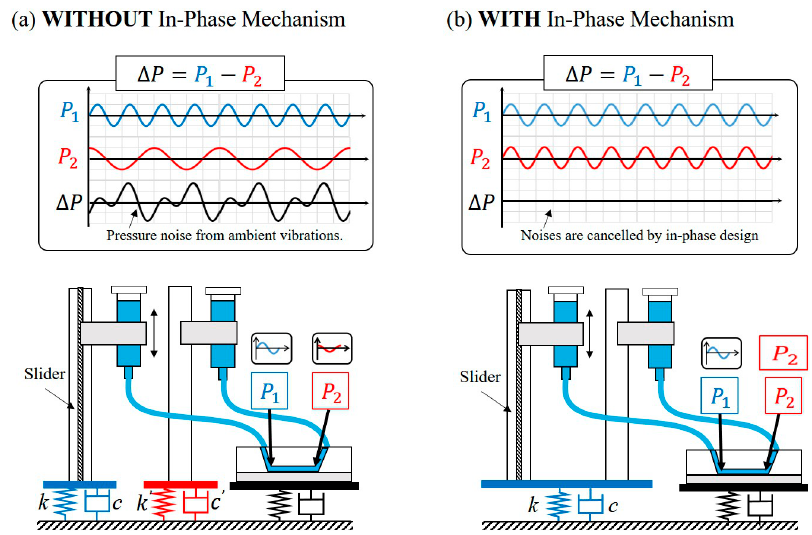
Figure 3. The idea of in-phase noise cancelation: ( a ) Without in-phase noise cancelation; ( b ) With in-phase noise